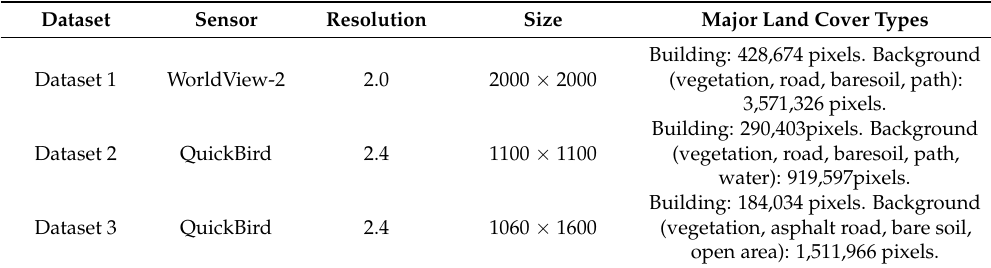
Table 2. Details of the test datasets.